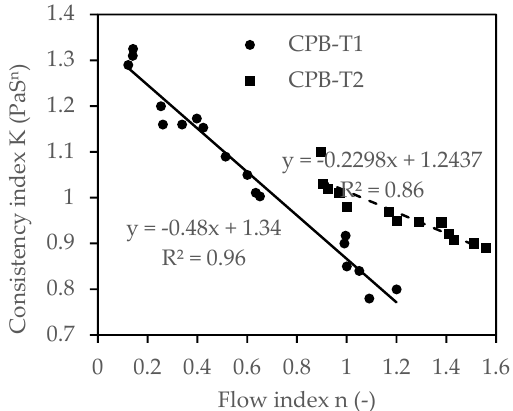
Figure 10. Correlation between the consistency index (K) and the flow behavior index (n) of the Herschel–Bulkley model for CPB-T1 and CPB-T2 mixtures presented in Table 1. The consistency index K decreases linearly with increasing flow index (n). The nega- tive slope of the correlation line depends on the type of tailings: 23% for CPB-T2 compared to 48% for CPB-T1. Rather than linear relationships, a decreasing logarithmic relationship